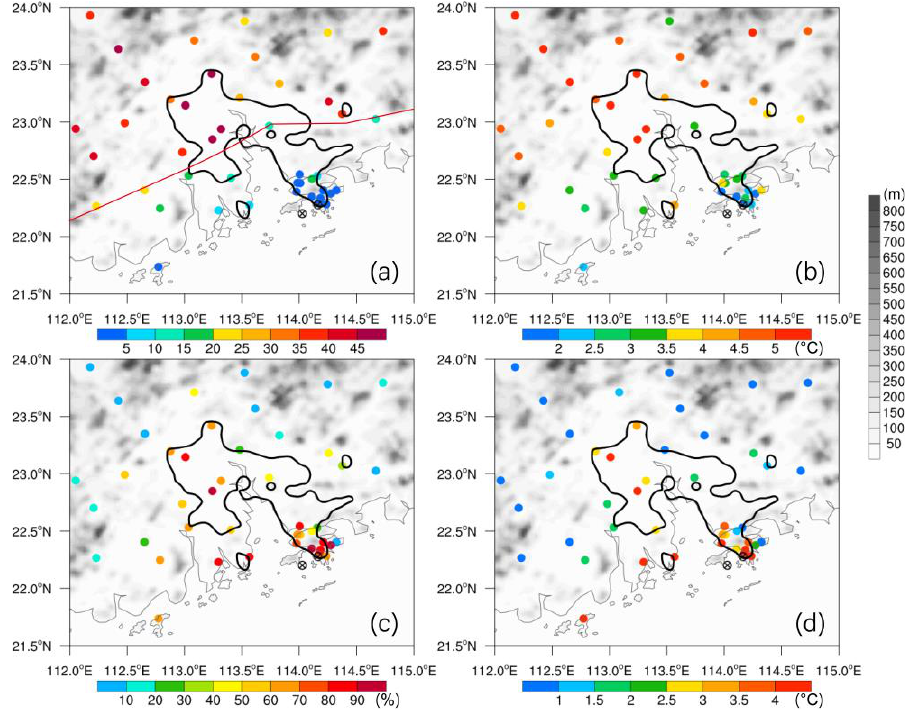
Figure 3. Spatial distribution of EHEs occurred over the PRD region in the warm seasons during 2008 – 2017. ( a ) Occurrence frequency of heatwaves. ( b ) Average cumulative intensity of heatwaves. ( c ) Proportion of warm nights in heatwaves. ( d ) Average cumulative intensity of warm nights. Gray shadings denote the topography. Black lines indicate the urban regions, and thin gray lines denote the provincial boundaries and coastlines. Crossed circles indicate that no heatwave occurred. The red line in ( a ) roughly separates the coastal and inland areas.